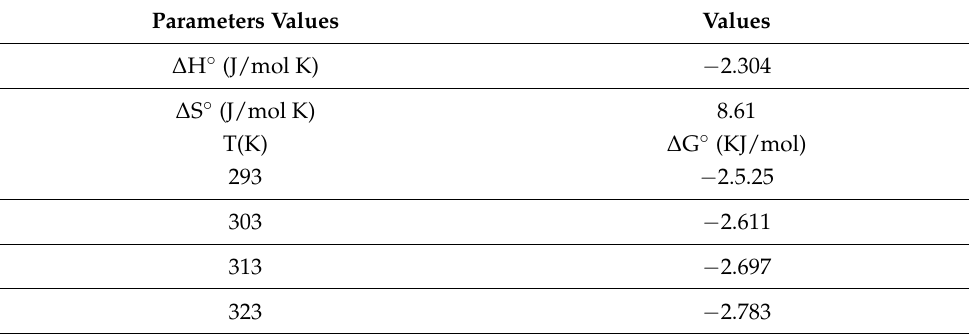
Table 5. Adsorption capacity of present adsorbent compared with those reported in literature.